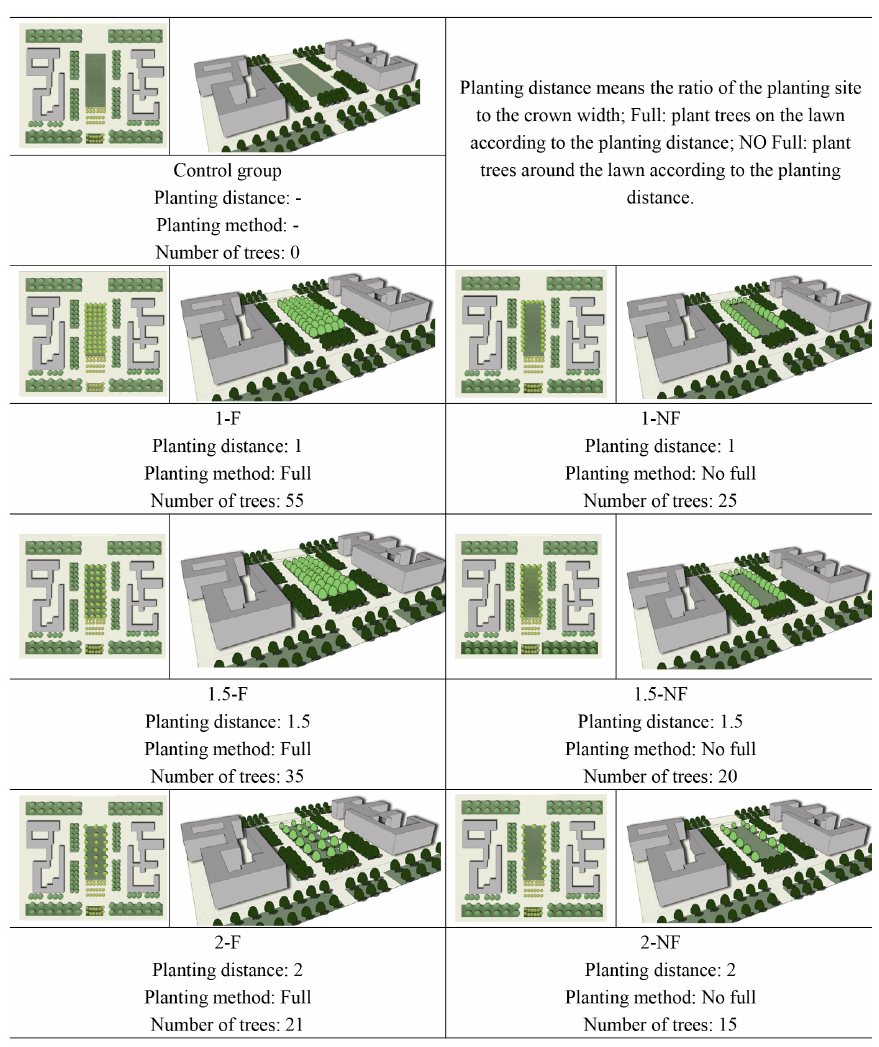
Figure 6. The six arbor arrangement methods to improve outdoor thermal comfort. Table 5. Review of outdoor thermal comfort investigation research in different